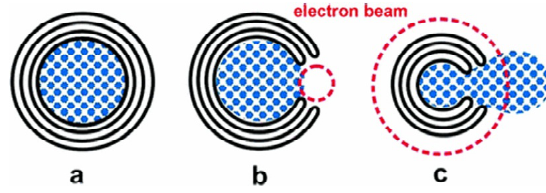
Fig. 6. Mechanism of the experiment used by Sun et al. [115] to study deformation of nano sized metal crystals: Graphitic shells encapsulating a metal crystal (a) are punctured by a focused electron beam (b). Successive electron irradiation of the container leads to the contraction of the shells and extrusion of the metal crystal (c). The red circles indicate the diameter of the electron beam. Reprinted with per- mission from Sun LT, Krasheninnikov AV, Ahlgren T, Nordlund K, Banhart F. 2008. Plastic Deformation of Single Nanometer-Sized Crystals. Physical Re- view Letters 101, [115]: (c) American Physical So-